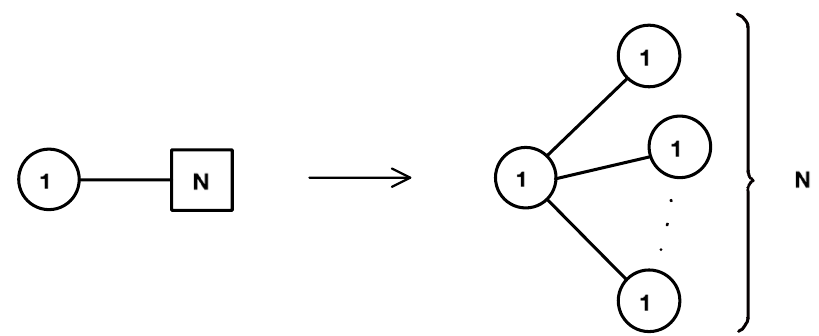
Figure 2. The quiver after compactifying the directions transverse to the